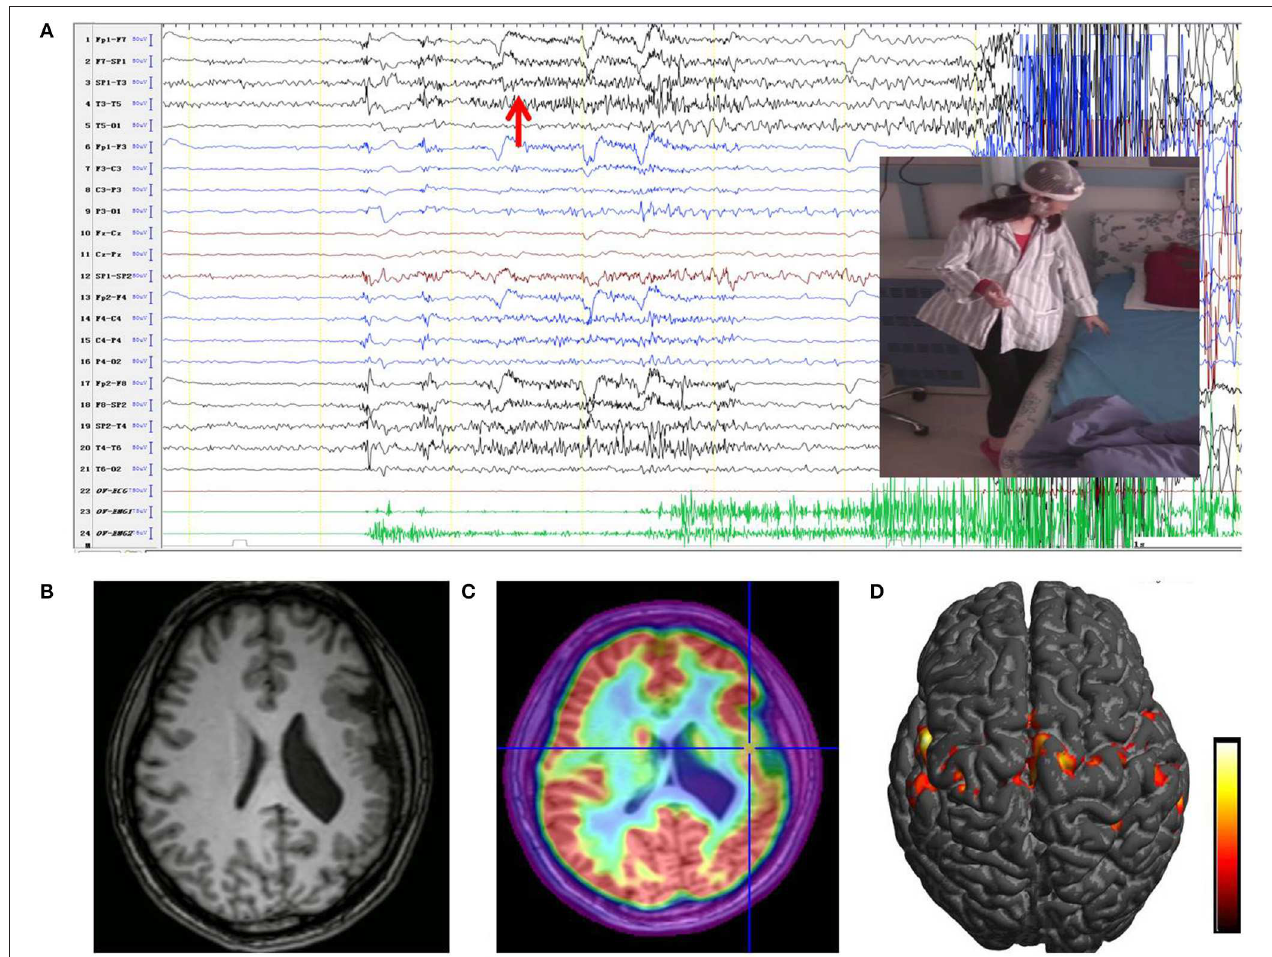
FIGURE 1 | (A) Ictal EEG originated in the left unilateral PMG. The first ictal modifications were characterized by left frontotemporal rhythmic fast activity (red arrow), followed by a focal left temporal alpha rhythm. Ictal clinical signs shown in the image corresponded to sudden sensation of stiffness and rigidity of the right limb; the patient was unable to stand stably. (B) An MRI scan showed a multi-lobar PMG involving the left frontal lobe, temporal lobe, insula, and temporo-parieto-occipital junctions. (C) PET/MRI imaging co-register of the patient showing significant hypometabolism in the middle part of the PMG. (D) Results of fMRI showed a significant increase in BOLD signal over the left PMG when moving the right leg, especially the perisylvian area (from red to yellow, the BOLD signal intensity increased). PMG, polymicrogyria; BOLD, blood oxygen level